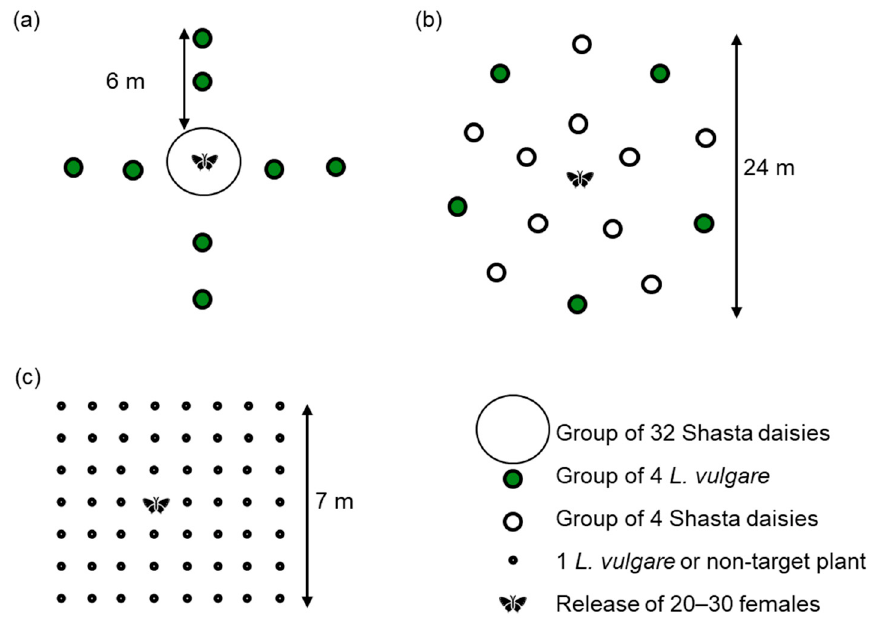
Figure 1. Designs of multiple-choice open-field tests conducted with Dichrorampha aeratana in ( a ) 2013, ( b ) 2014, and ( c ) 2014, 2017, and